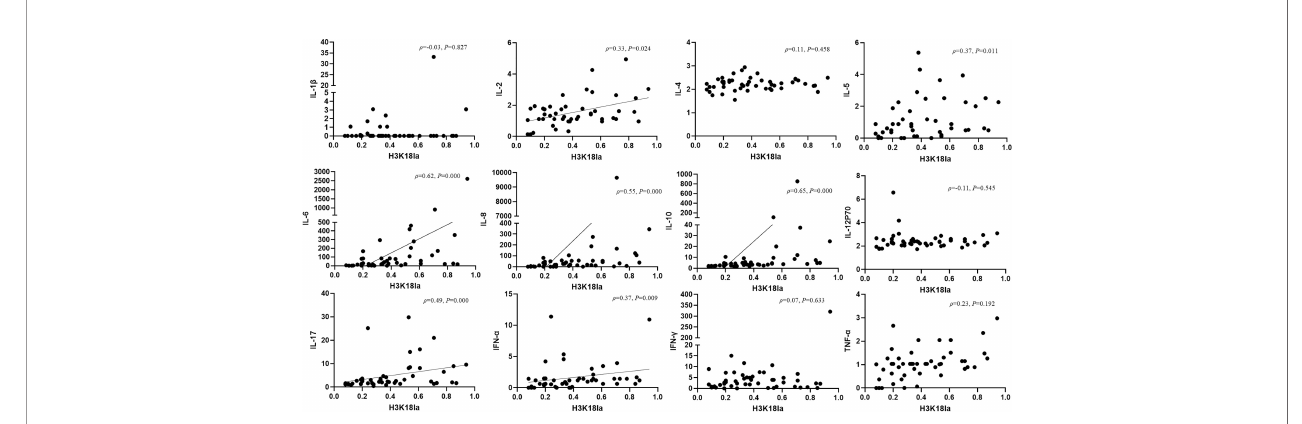
FIGURE 6 | H3K18 lactylation correlation with in fl ammatory cytokines. Protein level of H3K18la has a positive correlation with the serum levels of IL-2, IL-5, IL-6, IL-8, IL-10, IL-17, IFN- a (Spearman correlation coef fi cient 0.32, 0.37, 0.62, 0.55,0.65, 0.49 and 0.37 respectively; P =0.024, 0.011, 0.000, 0.000, 0.000, 0.000 and 0.009, respectively). H3K18la, relative density of H3K18 lactylation in western blotting. IL, interleukin, IFN, interferon, TNF-tumour necrosis factor. Serum levels of cytokines were assessed using a multiple microsphere immuno fl uorescence assay with fl ow cytometry. P values below 0.05 indicate statistical signi fi cance.